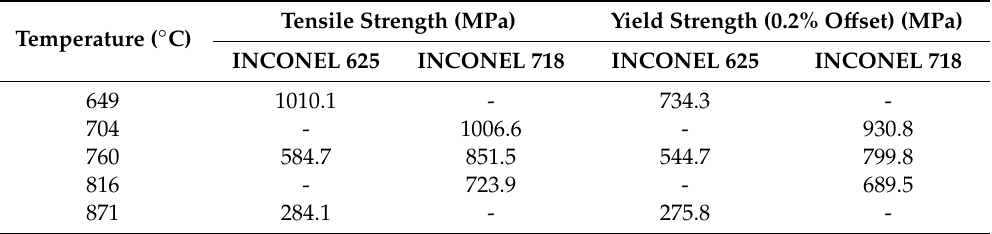
Table 3. High temperature strength of INCONEL alloy candidates.